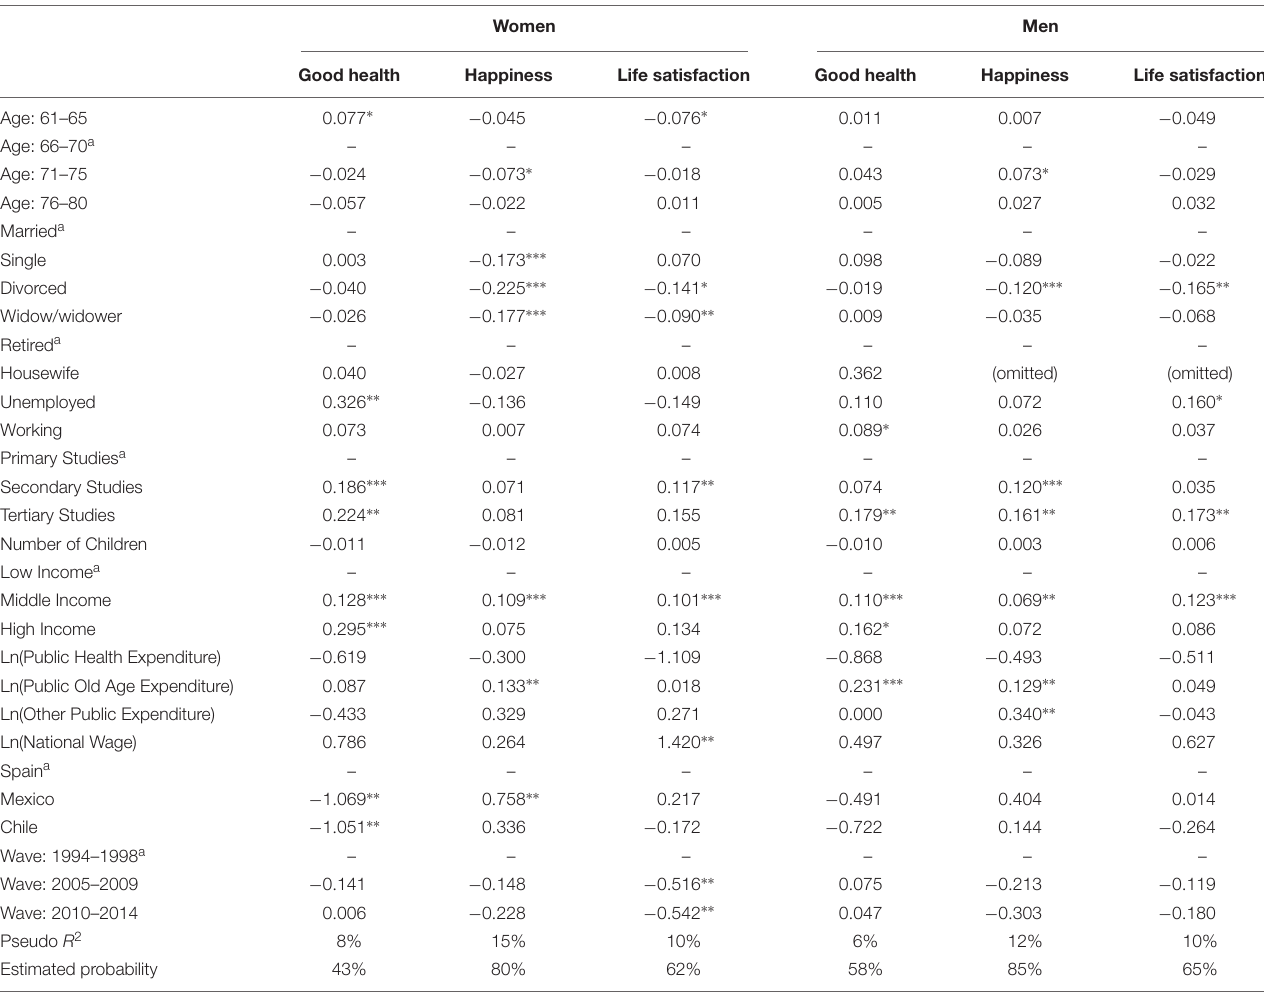
TABLE 4 | Estimations of wellbeing indicators: Model 1 by gender (Logit: dy/dx).